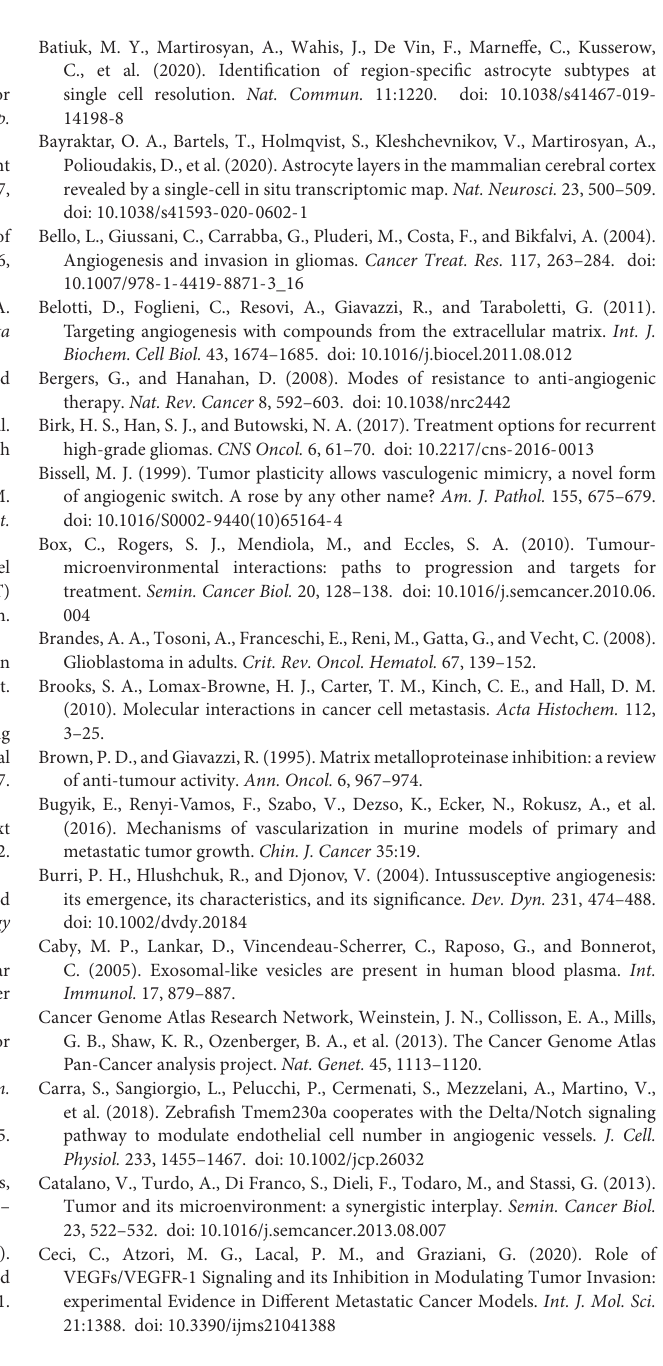
Supplementary Table 9 | All enriched pathways identified different between high or low TMEM230 expression in low grade (G2) astrocytoma of patients from DEG. Supplementary Table 10 | All enriched pathways identified different between high or low TMEM230 expression in high grade (G3) astrocytoma of patients from DEG. Supplementary Table 11 | All pathways identified common between high or low TMEM230 expression in all LGG of patients from DEG. Supplementary Table 12 | All pathways identified different between high or low TMEM230 expression in LGG and glioblastomas from